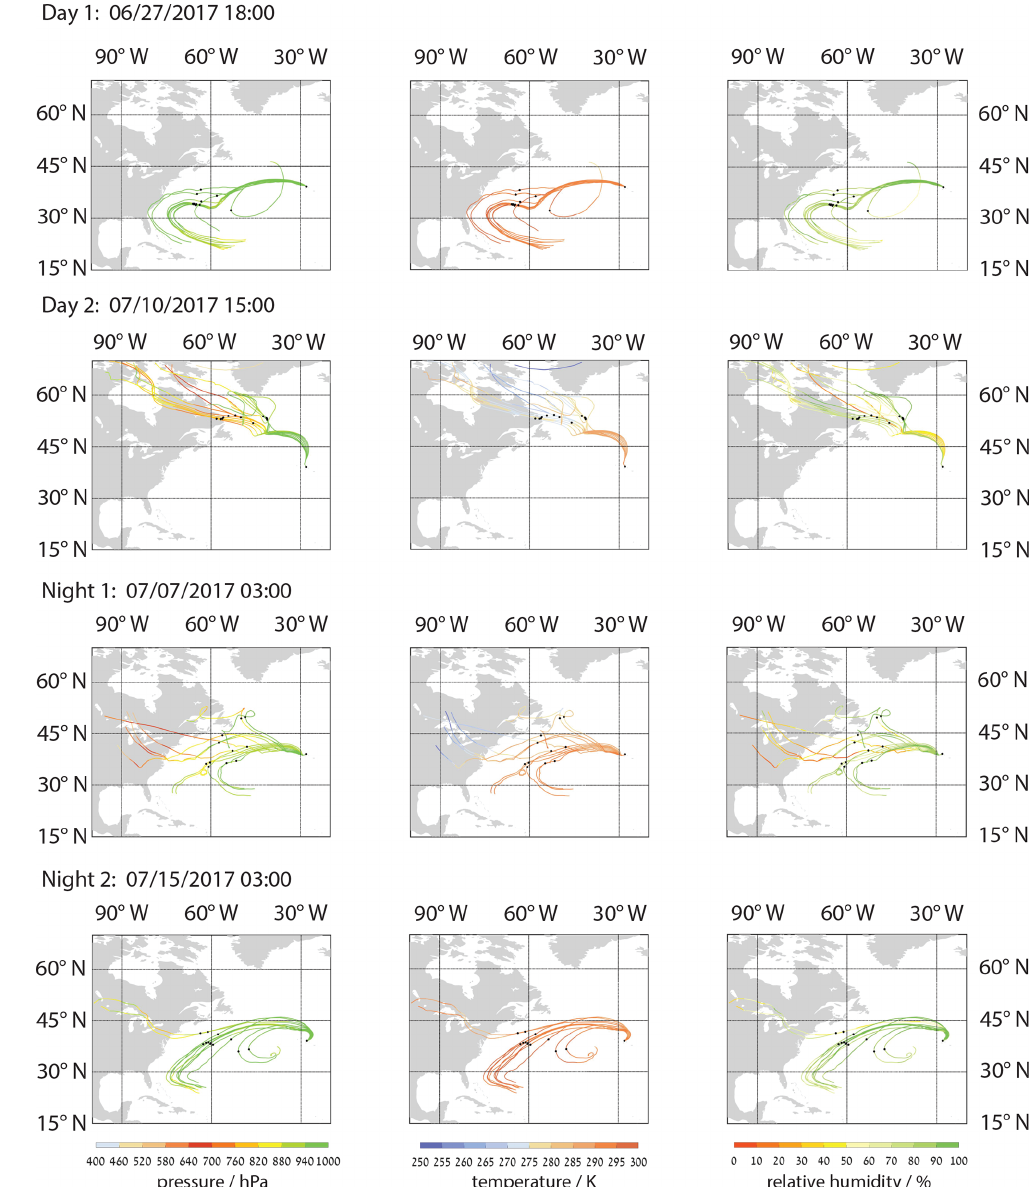
Figure 1. Representative backward trajectories for examined samples and corresponding sampling periods. Color coding indicates pressure level (hPa), temperature (K), and relative humidity (%) from left to right. Black dots mark the sampling site and the trajectory locations 5d prior to sampling. Local times are given and mark the time from which the 10d backward trajectories are